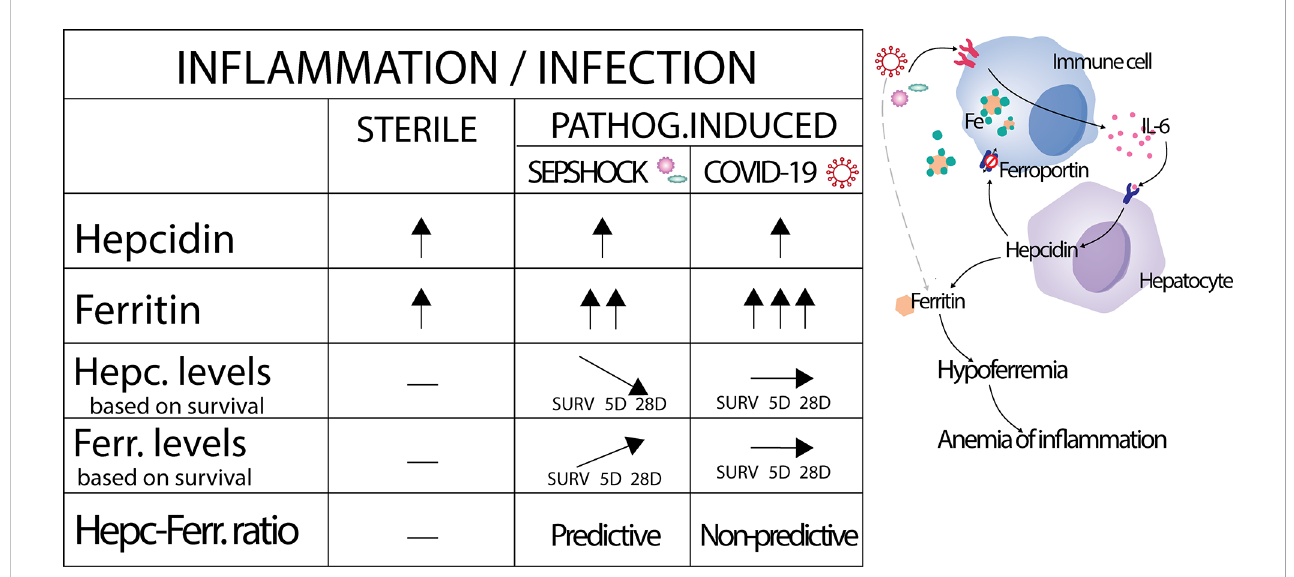
FIGURE 4 Graphical summarization of obtained results. Activation by sterile in fl ammation, but also by pathogens lead to increased production of hepcidin at the same manner. Subsequently, the same activation leads to pathogen dependent production of ferritin. In septic shock had levels of hepcidin and ferritin inverse dynamics based on survivorship and led us to prepare hepcidin-ferritin ratio with capacity to predict the prognosis of septic shock